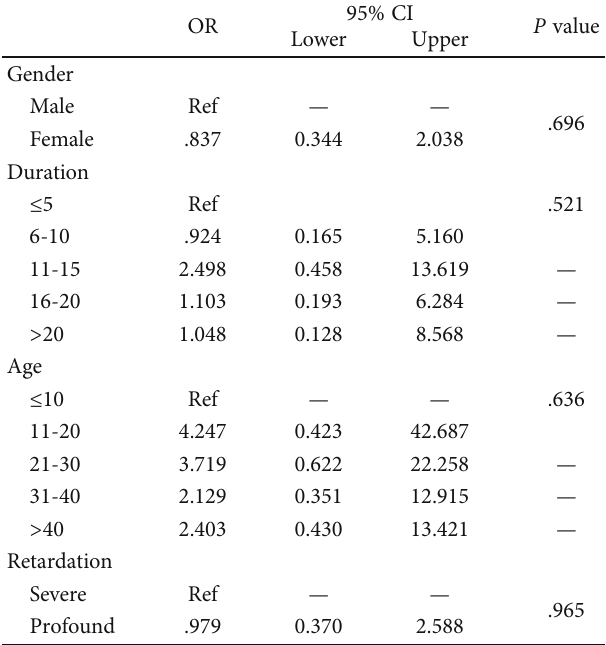
Table 6: Results of logistic regression measuring association between the study variables and parasitic